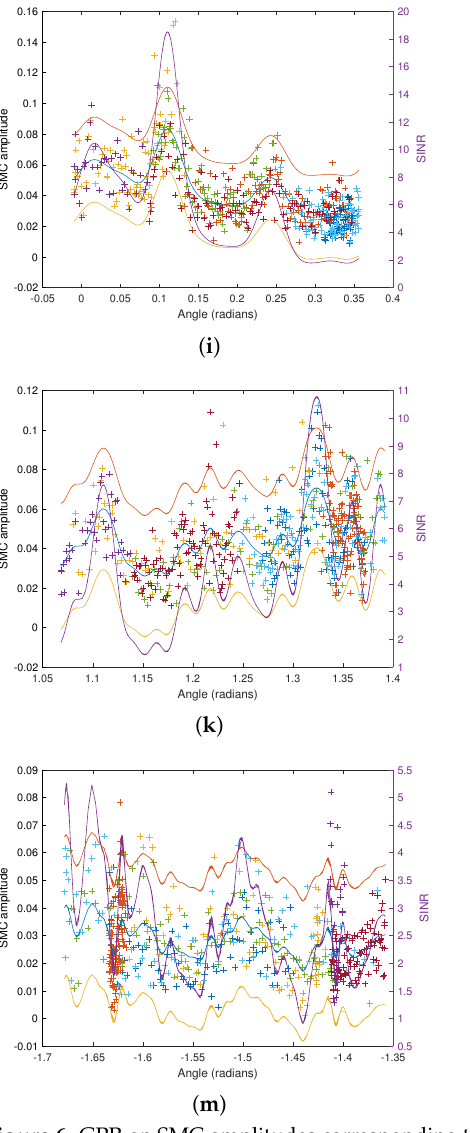
Figure 6. GPR on SMC amplitudes corresponding to: ( a ) LOS link, ( b ) reflection on EPB, ( c ) reflection on WW, ( d ) reflection on the south part of the room containing various materials, e.g., white board,